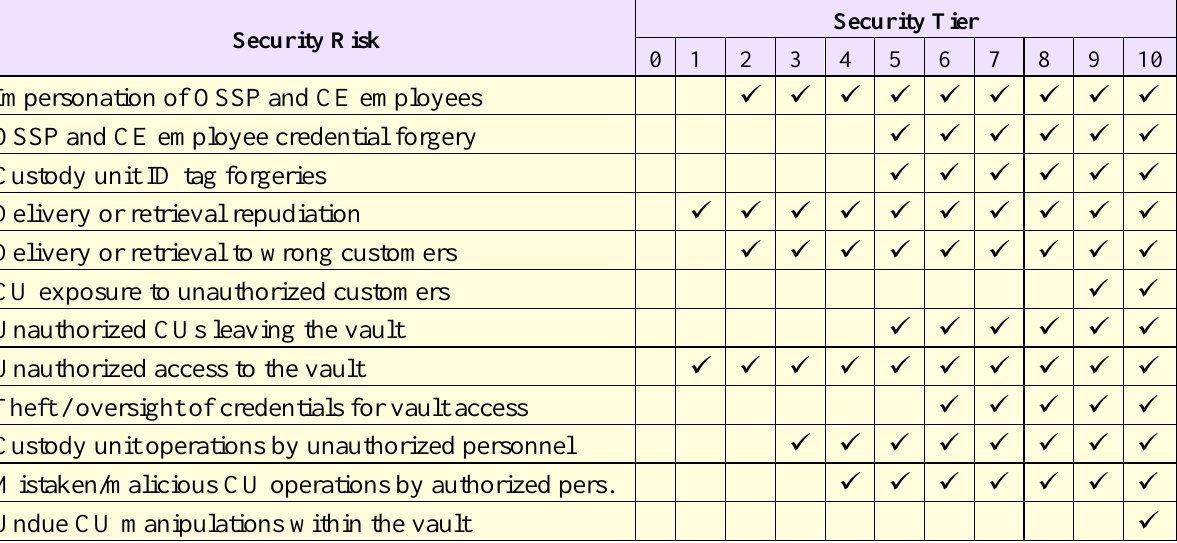
Table 2. Security risks mitigated in the different security